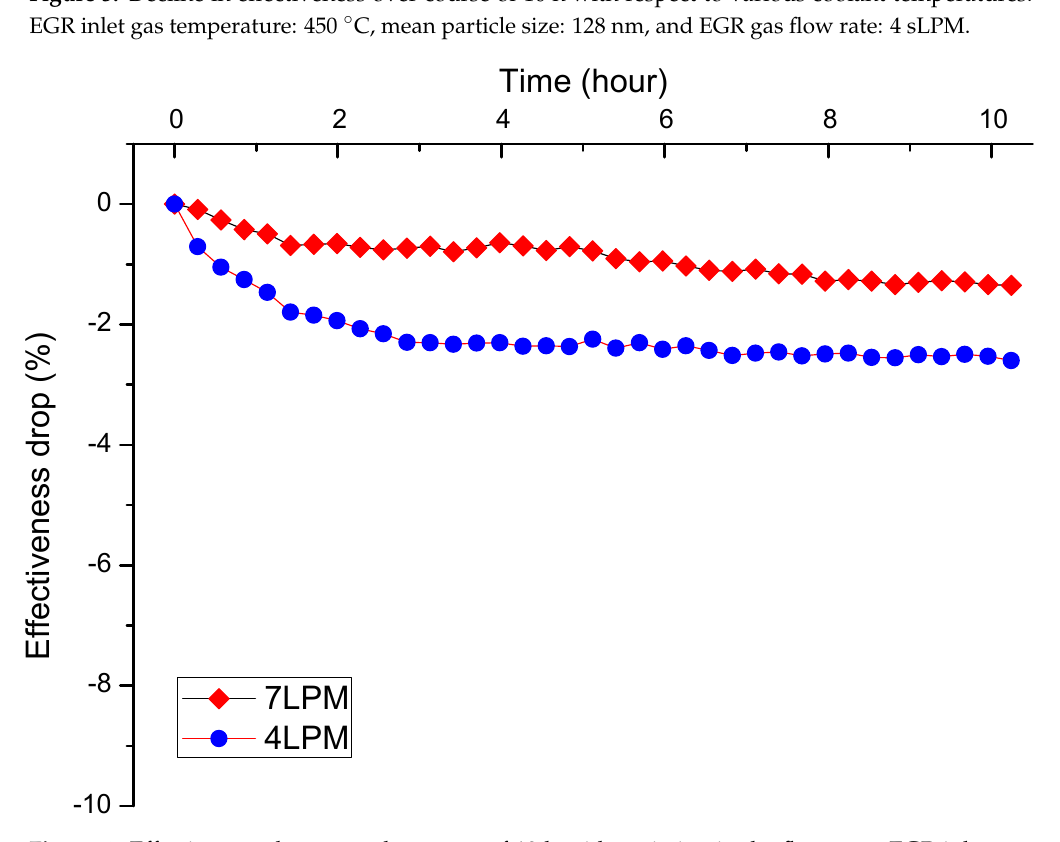
Figure 4. Effectiveness drop over the course of 10 h with variation in the flow rate. EGR inlet gas temperature: 450 °C, mean particle size: 128 nm, and coolant temperature: 80 °C.